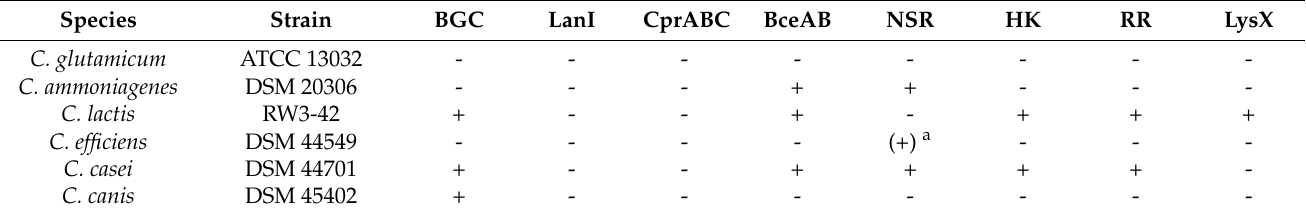
Table 2. Corynebacterium strains chosen for further characterization and their resistance traits.